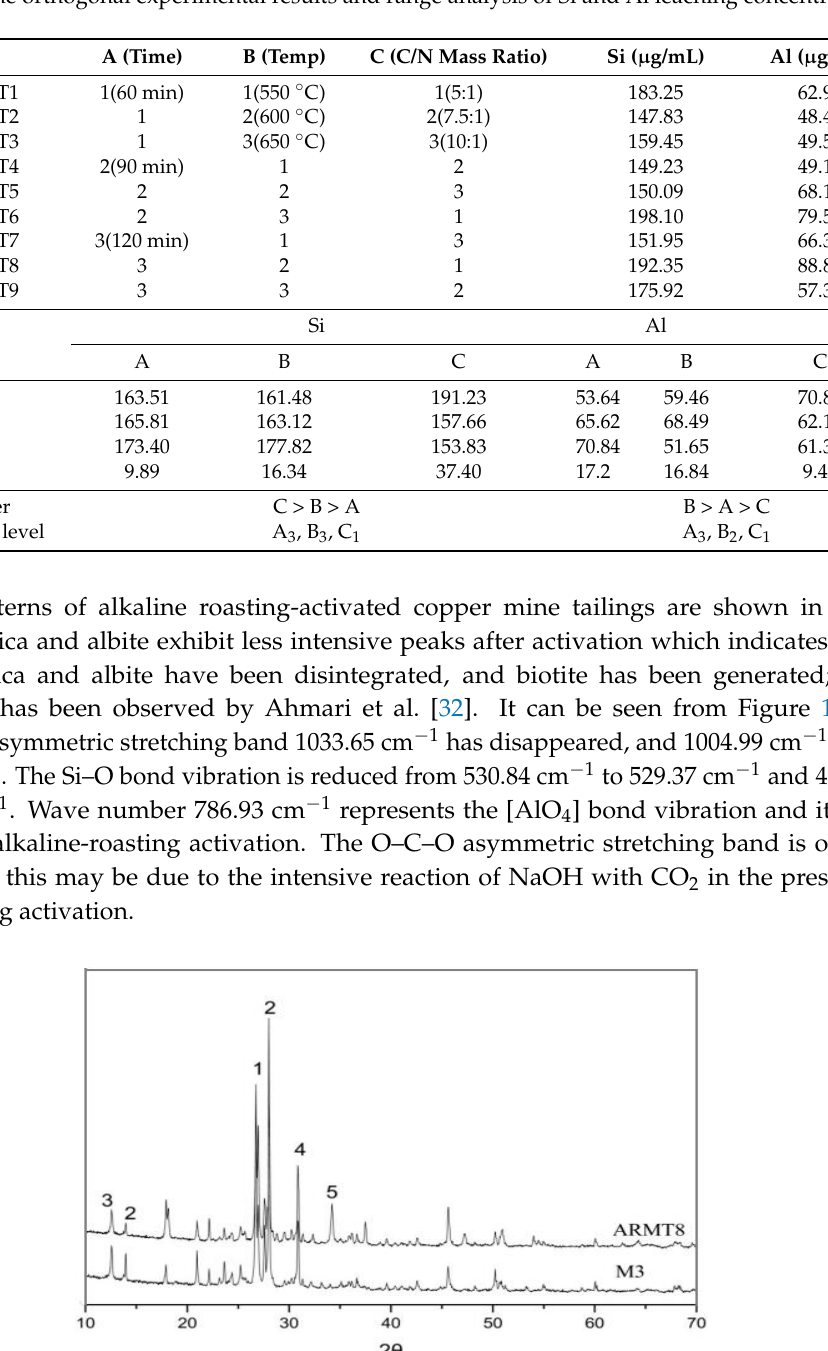
Table 7. The orthogonal experimental results and range analysis of Si and Al leaching concentrations.